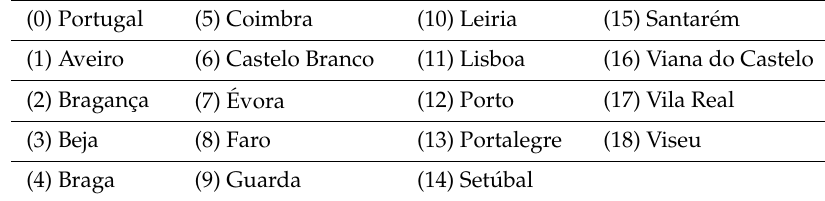
Table 2. District reference